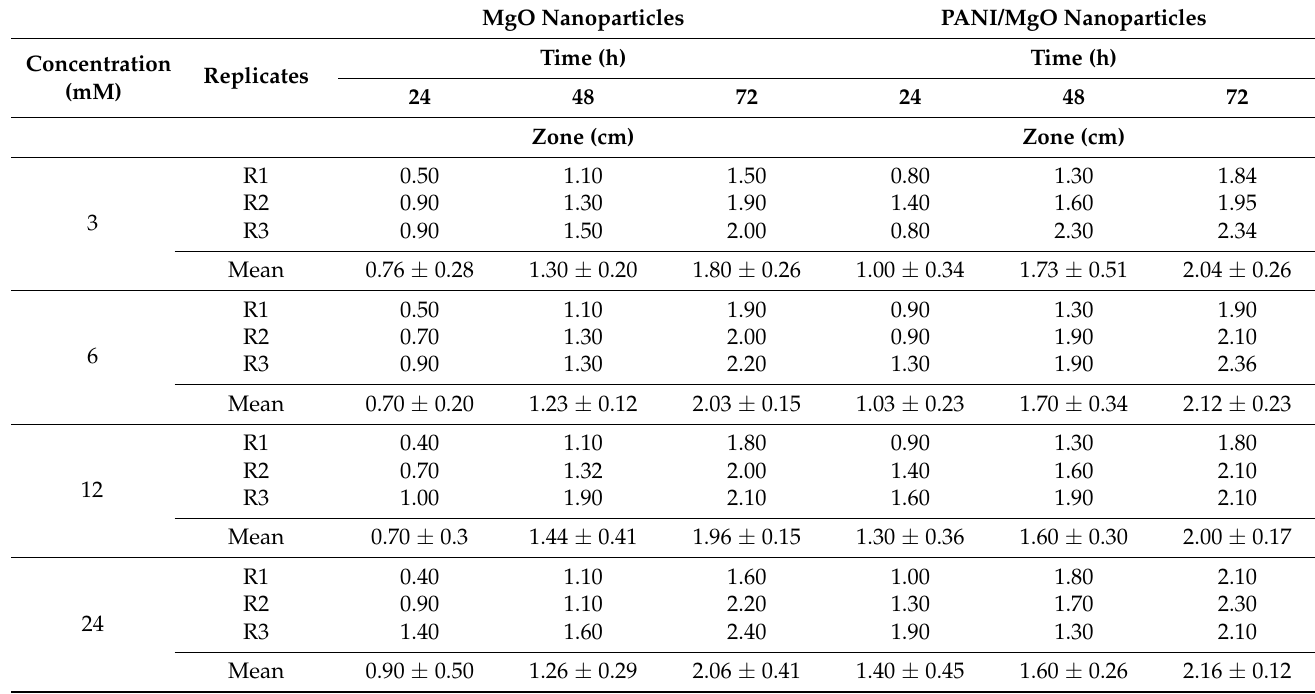
Table 1. Concentration and time-dependent growth inhibition of Aspergillus niger by MgO and PANI/MgO nanoparticles. MgO